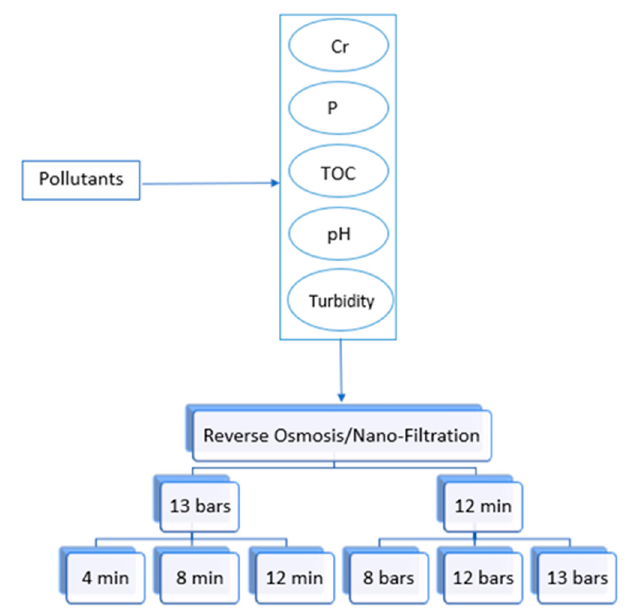
Figure 3. RO and NF experimental plan.